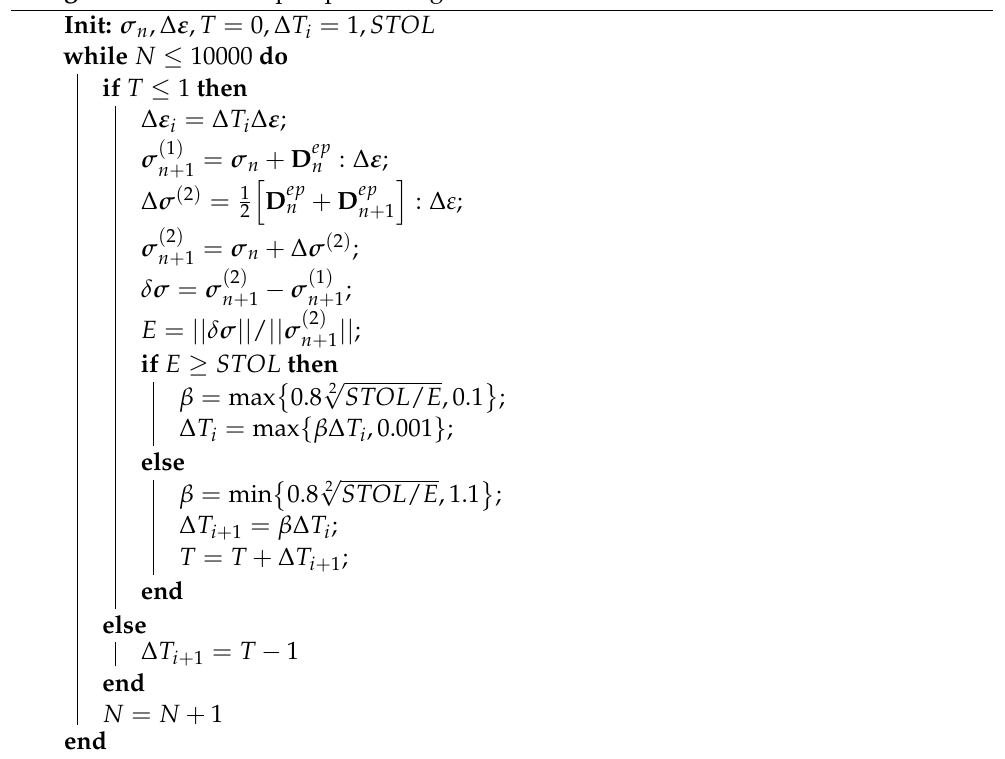
Algorithm 1: Two-Step Explicit Integration Method with Error